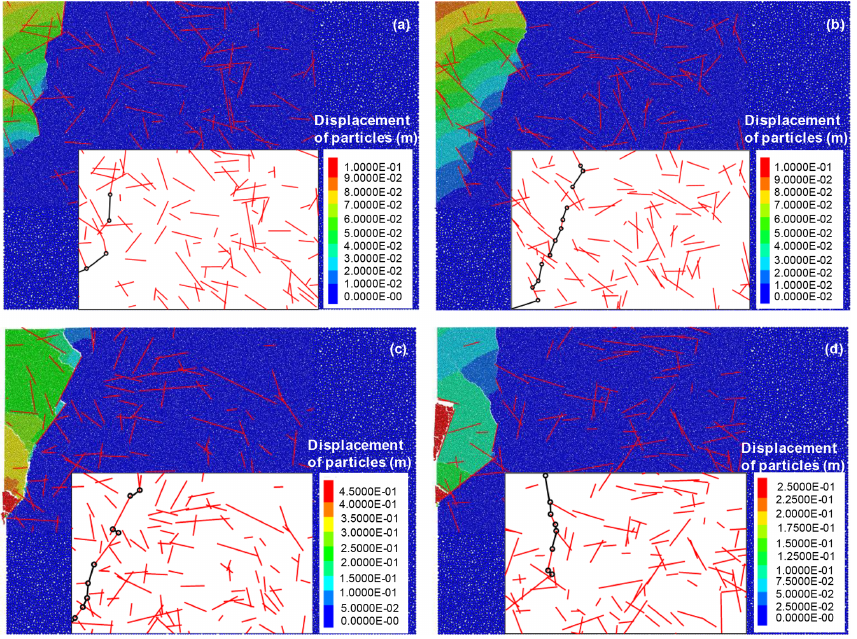
Figure 11. Four different critical slip surfaces of rock slopes with four different DFN models. The factors of safety of (a)–(d) are 12, 15, 21, and 17.